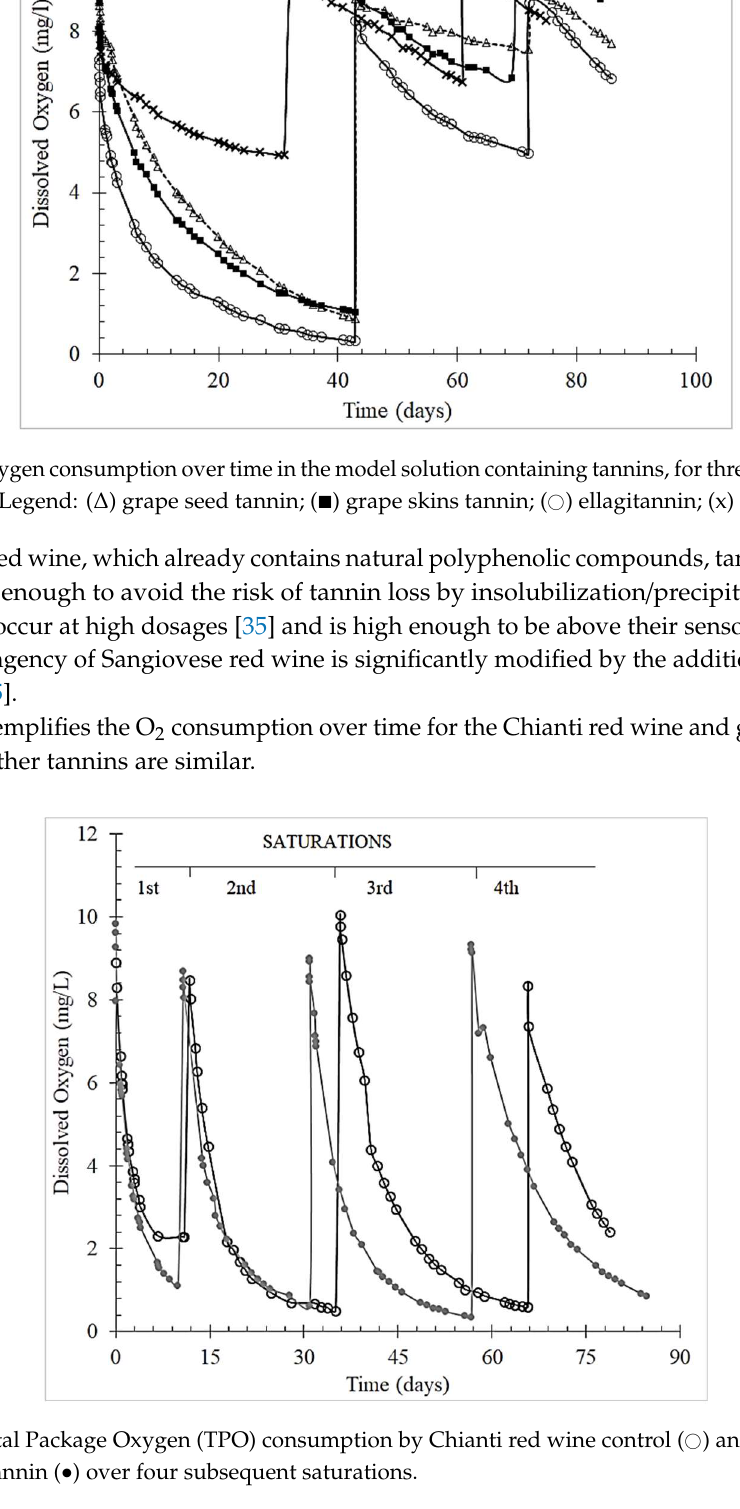
Figure 2. Total Package Oxygen (TPO) consumption by Chianti red wine control ( ○ ) and added with grape skin tannin ( • ) over four subsequent grape skin tannin (●) over four subsequent saturations. (cid:35)